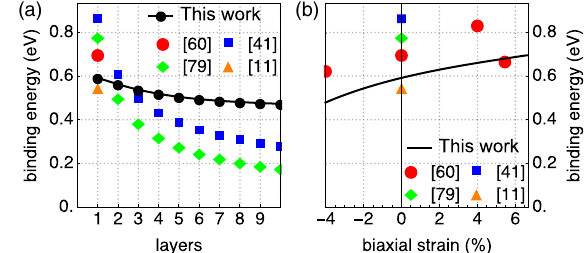
FIG. 6. (a) Exciton binding energy in unstrained BP as a function of number of layers. (b) Exciton binding energy in a BP monolayer as a function of biaxial strain. Colored symbols correspond to the indicated